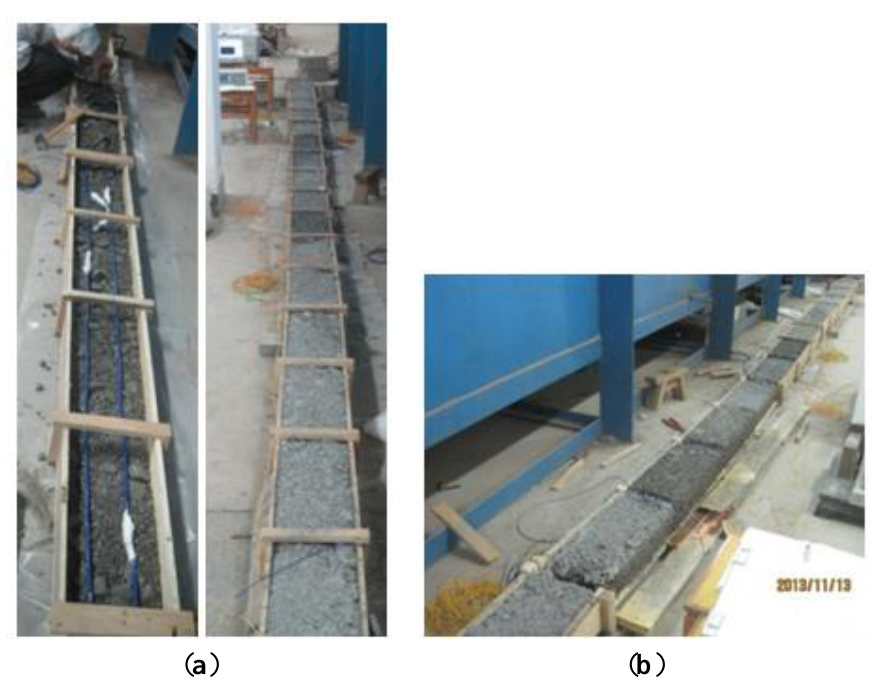
Figure 14. Cement stabilized layer embedded with quasi-distributed OF sensors. ( a ) Sensor layout and structure; ( b ) Cement structure with large